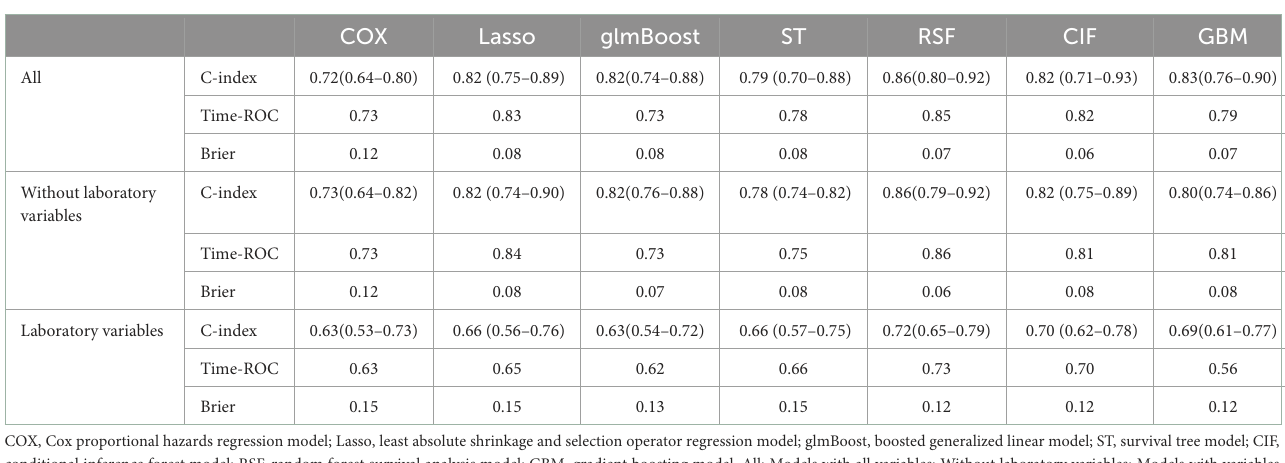
TABLE 2 Performance of the models for predicting all-cause mortality in internal validation cohort.